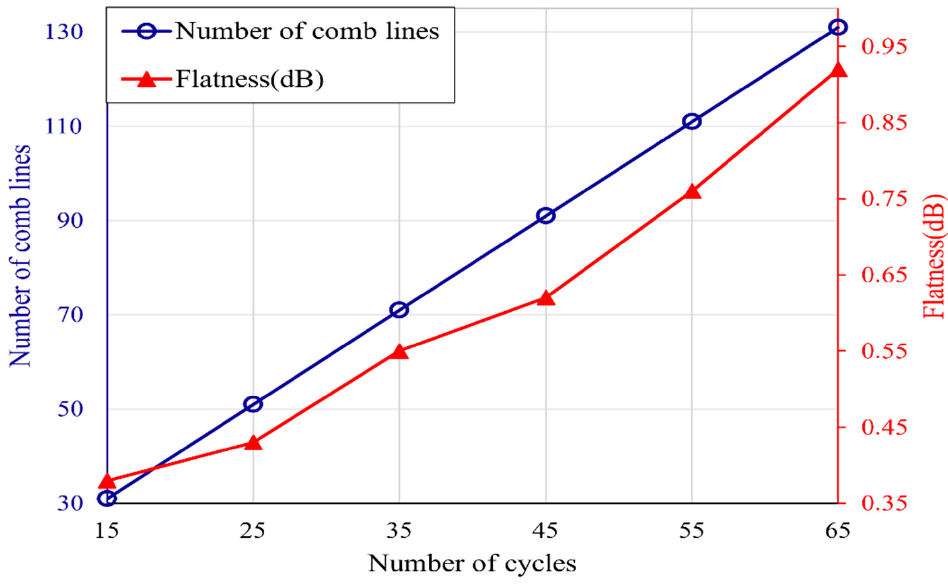
Figure 4. The number of comb lines and flatness of the generated OFC under different cycles.